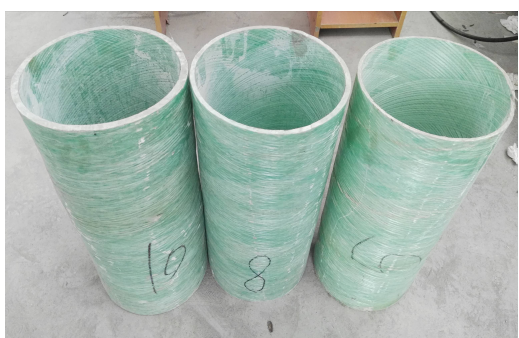
Figure 1: Three types of GFRP tubes with different diameter- thickness ratio